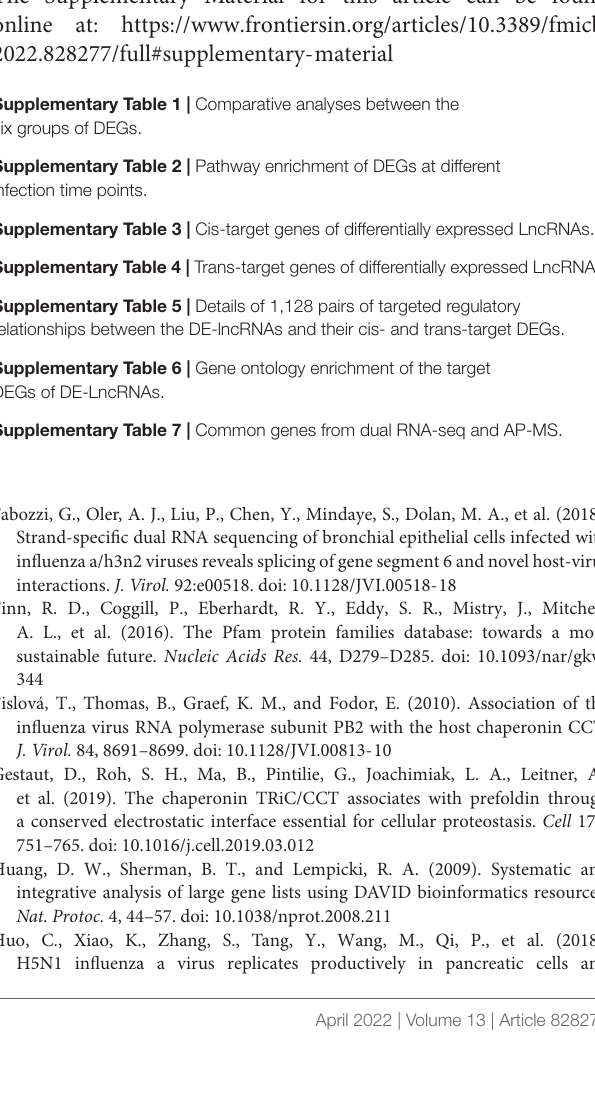
Supplementary Table 1 | Comparative analyses between the six groups of DEGs. Supplementary Table 2 | Pathway enrichment of DEGs at different infection time points. Supplementary Table 3 | Cis-target genes of differentially expressed LncRNAs. Supplementary Table 4 | Trans-target genes of differentially expressed LncRNAs.